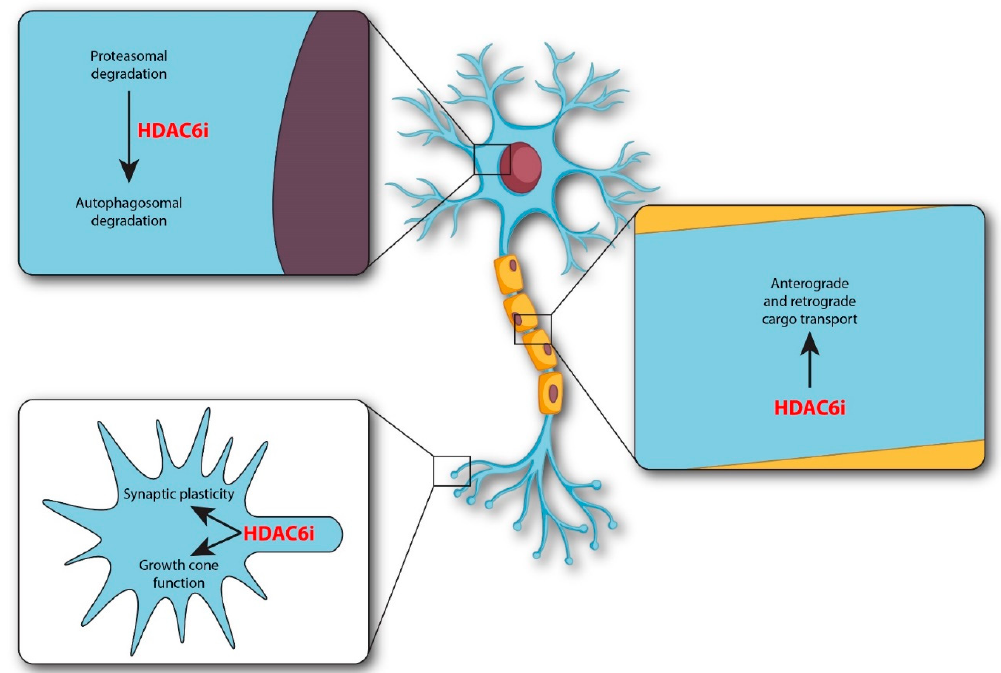
Figure 2. Cellular sites of HDAC6 inhibitors in neurodegenerative diseases. HDAC6 inhibitors (HDAC6i) regulate a variety of events including growth cone function, synaptic plasticity, transport, and autophagosomal degradation. The intracellular sites of regulation are indicated at the level of growth cone, processes, and soma.